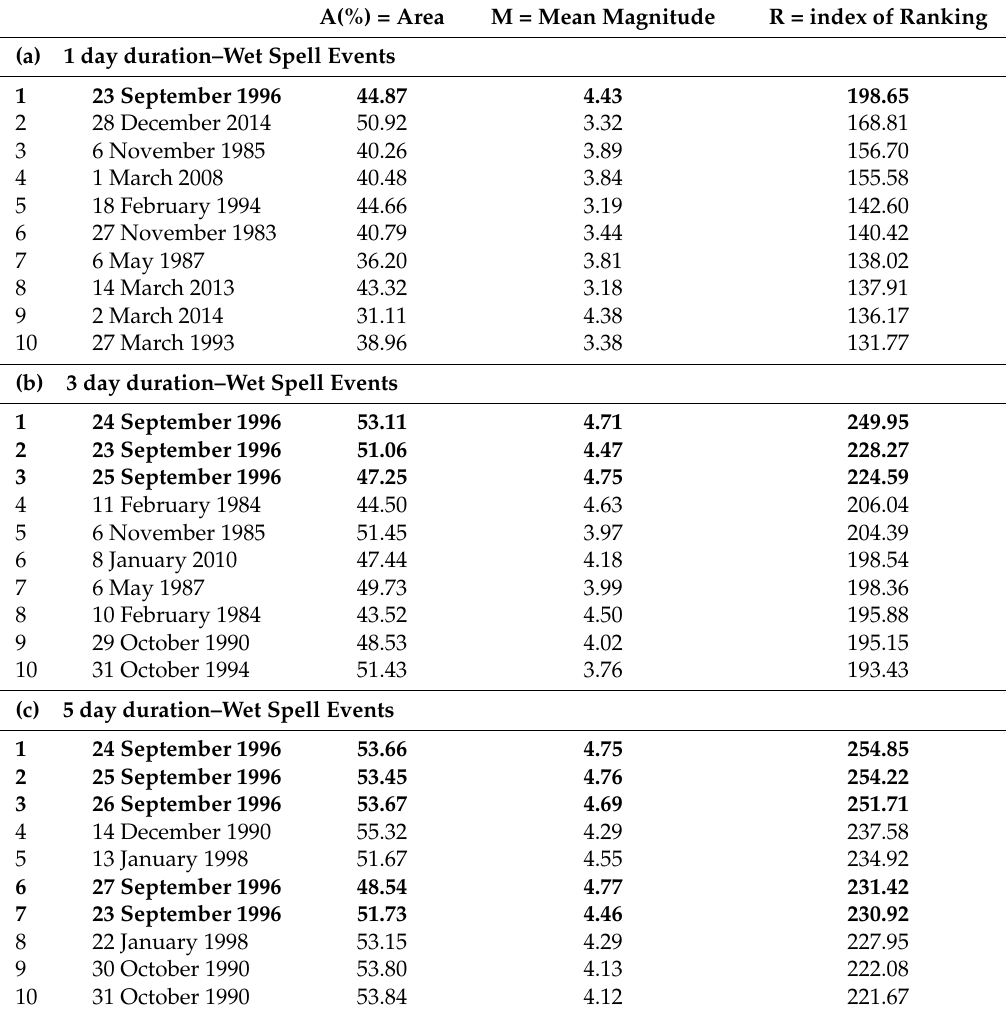
Table 1. The top ten wet spell events in the Danube River Basin (DRB) according to the different length of the events (1, 3, 5, 7, and 10 days). Column denoted with A corresponds to area of the DRB in percentages that had precipitation anomalies above 2 std (standard deviation). Column M corresponds to mean magnitude of precipitation anomalies of A, and the last column denoted with R represents the final index of ranking of wet spell events. The final column (R) is the magnitude of the events. In bold are represented wet spell events in different durations that we took into consideration and all events include the most anomalous one for the 1-day ranking identified event with an initial day on 23 September 1996. A(%) = Area M = Mean Magnitude R = index of Ranking